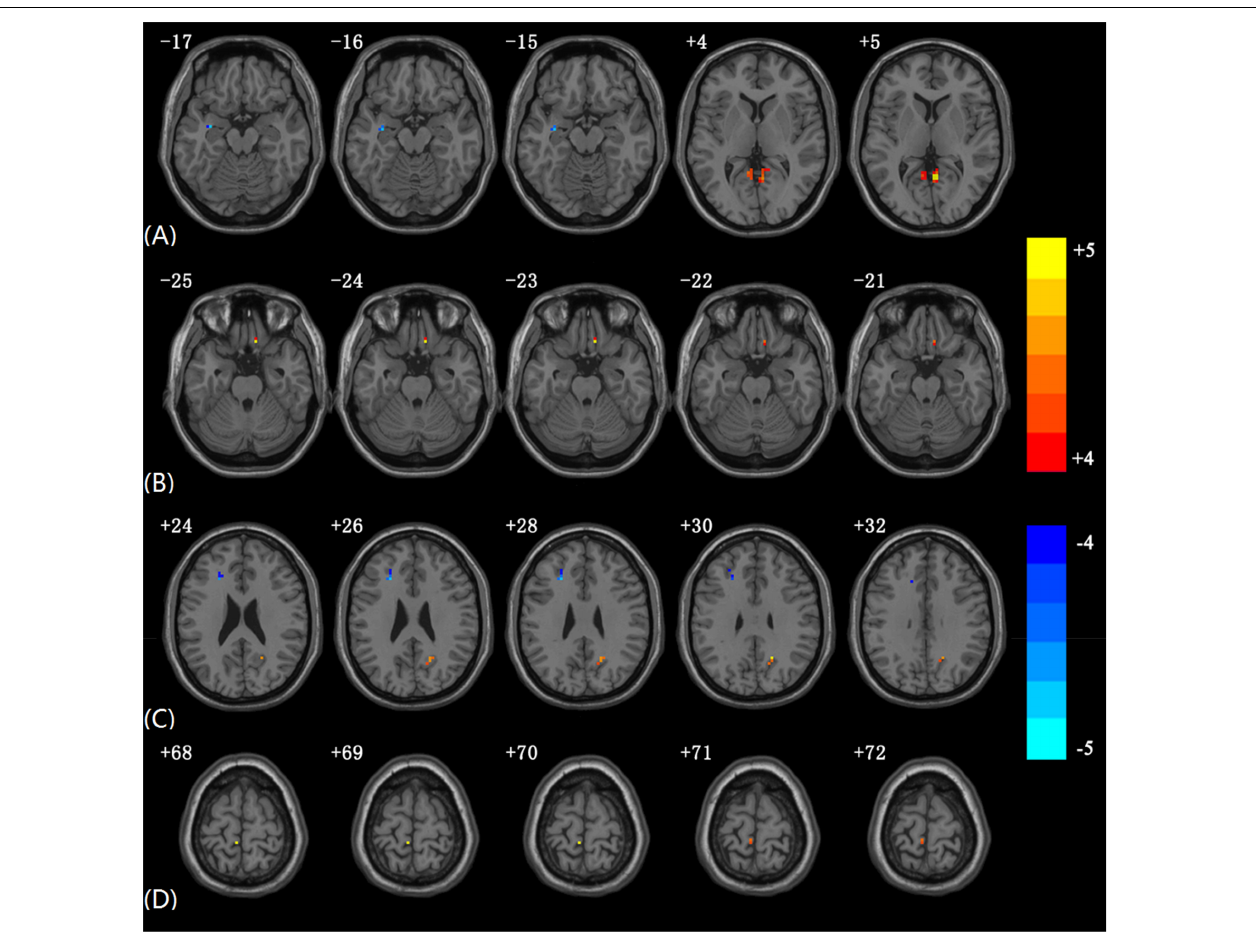
FIGURE 1 | Significantly altered EC in AMs compared to HCs using voxel-wise EC analysis. The color scale represents T -values. (A) Altered EC from PVC.L to other brain regions in AMs compared to HCs. (B) Altered EC from other brain regions to PVC.L in AMs compared to HCs. (C) Altered EC from PVC.R to other brain regions in AMs compared to HCs. (D) Altered EC from other brain regions to PVC.R in AMs compared to HCs (In each subgraph, only the slices with obvious differences are presented; the subgraphs including slices without significant differences EC are provided in Supplementary Figure 1